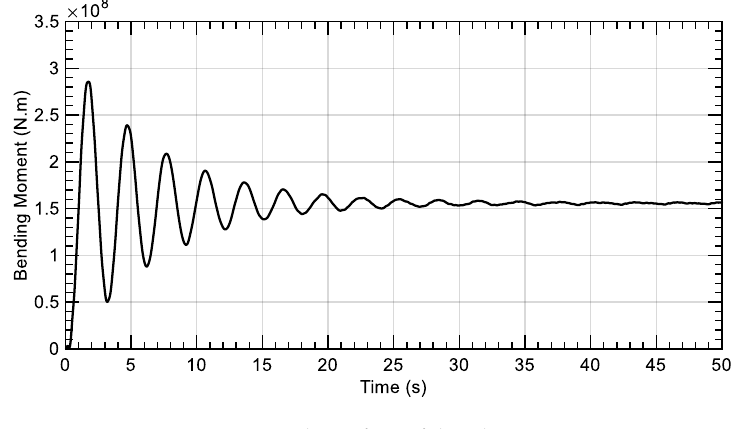
Figure 19. Tower-base, fore-aft bending moment.